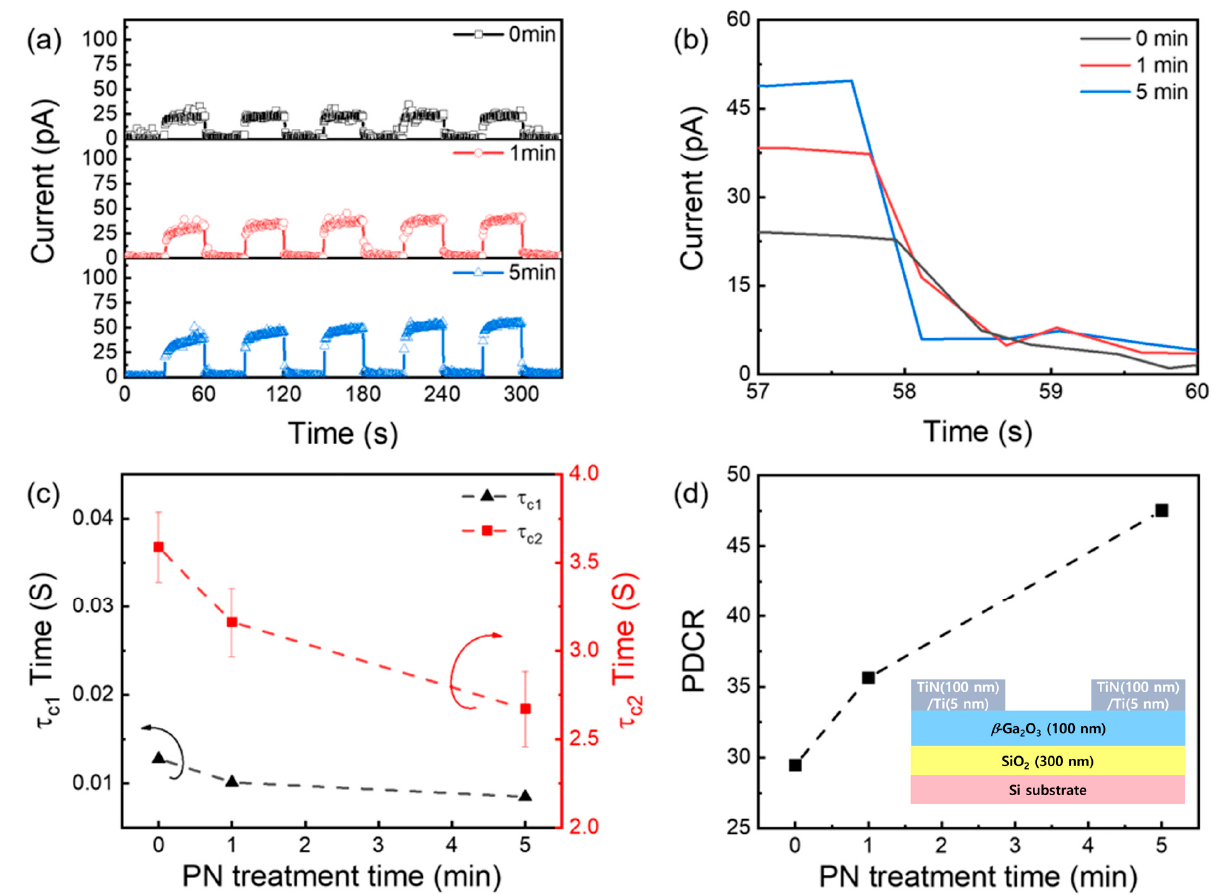
Figure 3. ( a ) Transient photo-response, ( b ) typical photocurrent decay curves, ( c ) two photocurrent decay time constants ( τ c1 and τ c2 ), and ( d ) PDCR of β -Ga 2 O 3 MSM PDs at different PN treatment times. In the inset, schematic cross-sectional image of the MSM PD. The arrows indicate each axis.